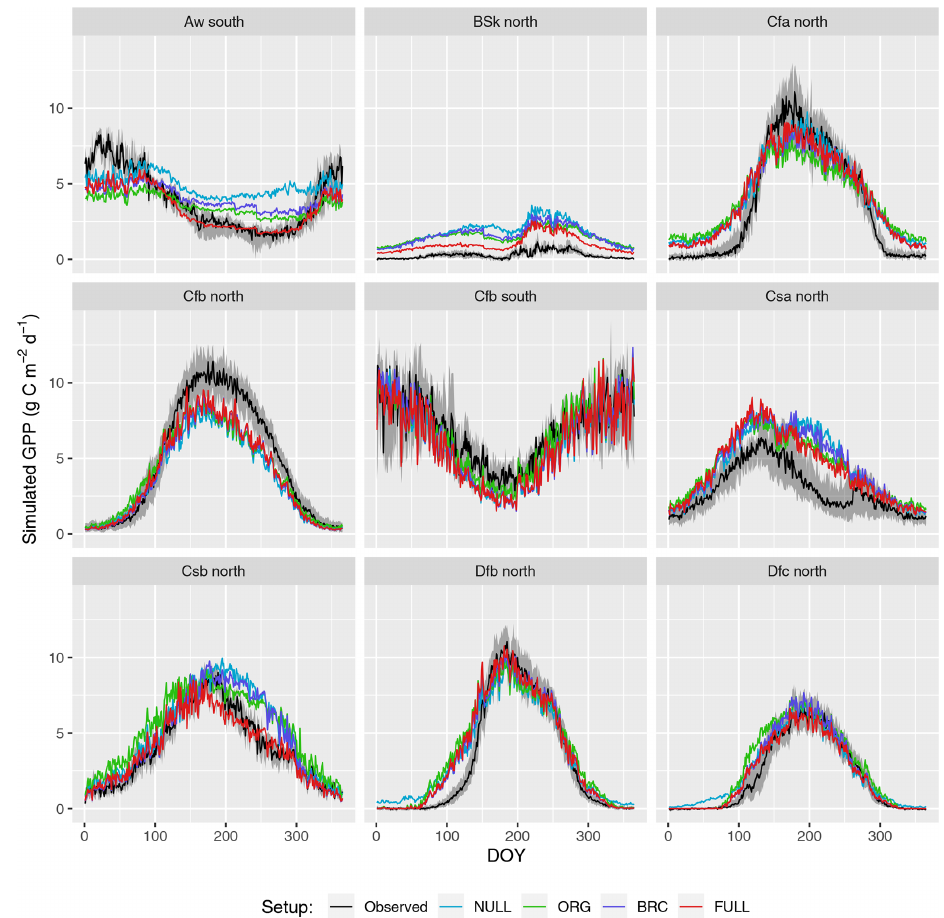
Figure 4. Mean seasonal cycle. Observations are given by the black line and grey band, representing the median and 33%/66% quantiles of all data (multiple sites and years) pooled by climate zone. Coloured lines represent different model setups. The annotation above each plot specifies the climate zone (see Table 2). Only climate zones are shown here for which data from at least five sites were